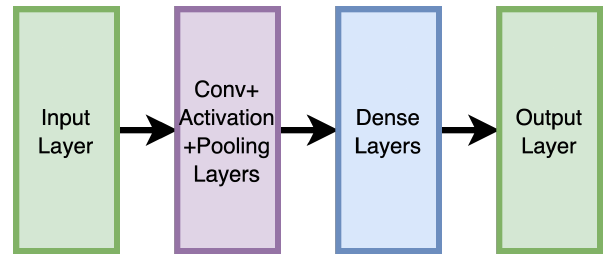
Figure 3. Sample architecture of plain networks.